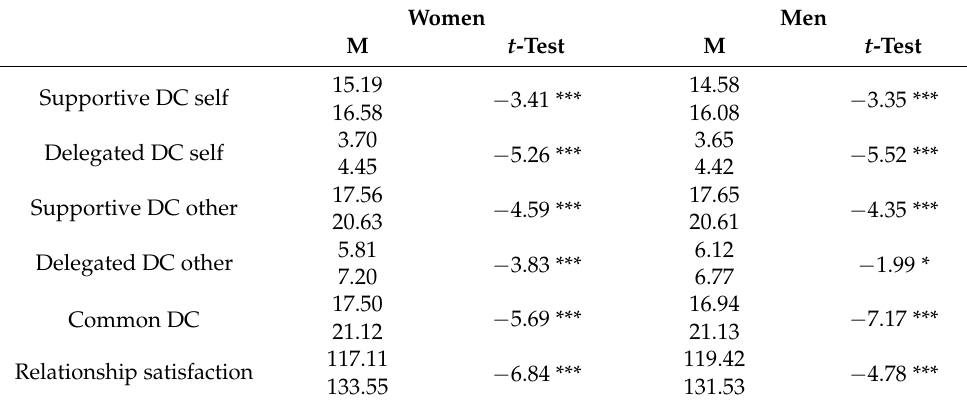
Table 2. Differences between secure and insecure individuals.